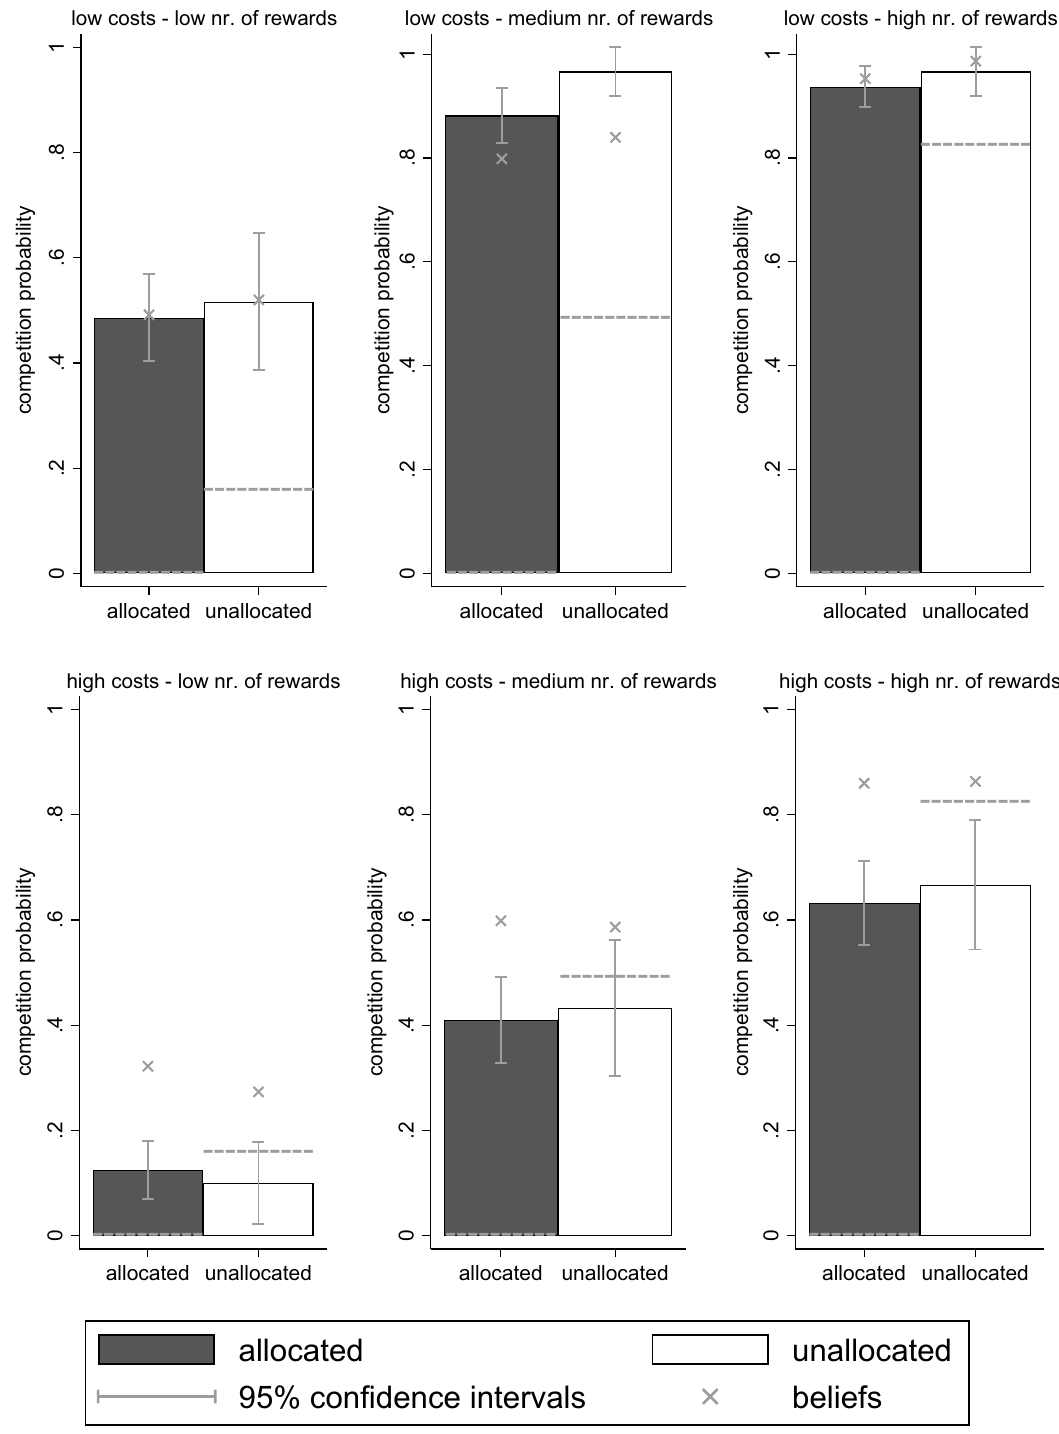
Figure 1. Competition in the allocated and unallocated condition. Mean competition proportions per condition and setting are shown with bars, including 95% confidence intervals with vertical spikes. Mean beliefs on the proportion of competitors are added with ‘x’ markers. The collectively efficient competition probabilities are added with horizontal dashed lines. We observe that mean competition and beliefs are very similar in the allocated and unallocated condition for all six